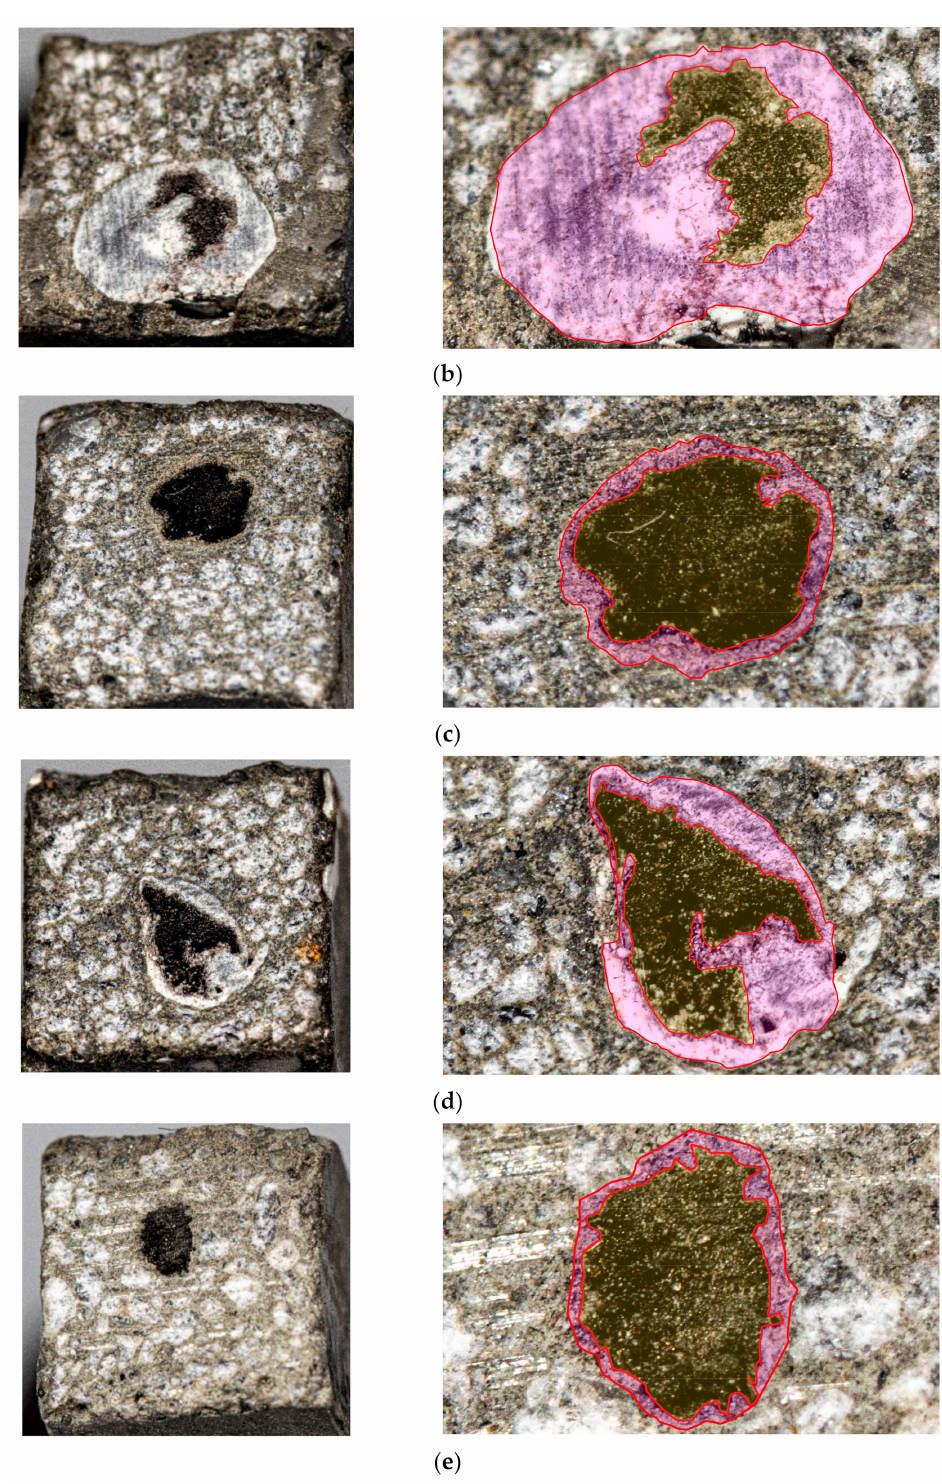
Figure 11. Cross-sections of beam samples. Left panels: whole cross-section area of beam sample. Right panels: detailed view of the cross-section area with the saturated part of the carbon roving in red and the non-saturated carbon roving in yellow: ( a ) Experimental series A—pressure saturation CEM 42.5 R; ( b ) Experimental series B—pressure saturation CEM 52.5 R; ( c ) Experimental series C—surface saturation by a roller CEM 42.5 R; ( d ) Experimental series D—surface saturation by a roller CEM 52.5 R; ( e ) Experimental series E—without